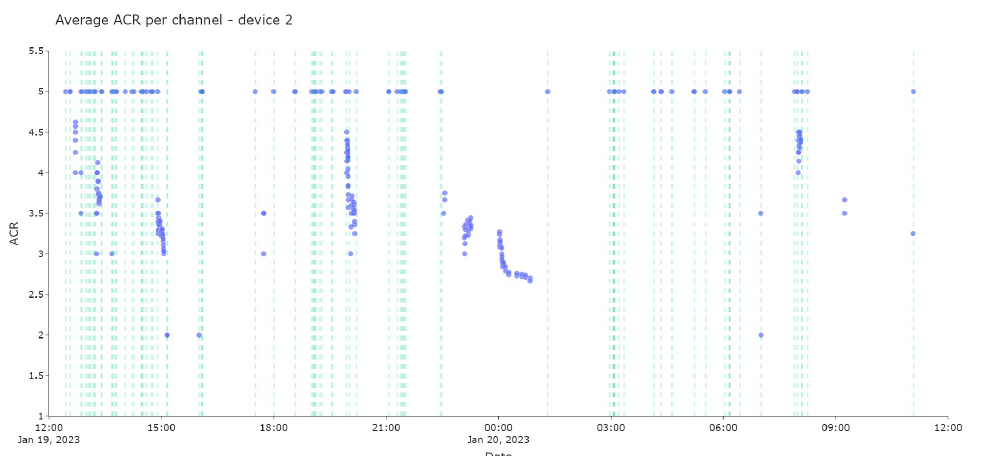
Figure 13. Average ACR grade for given channel for second